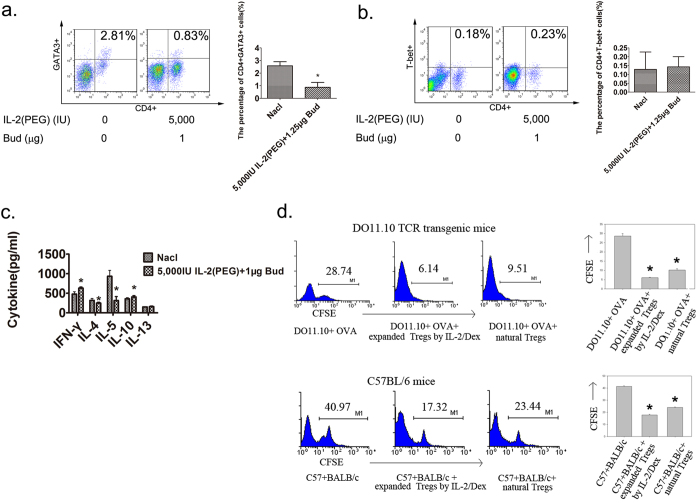
Detection of Th2 cell and cytokines in BALF.Measurements of expanded Treg cells for antigen-specificity. The mechanism of combined use of glucocorticoid and IL-2 in alleviating asthma rested on expanding antigen-nonspecific Treg cells, with a decrease in T helper 2 (Th2) cells and Th2-associated cytokines in the airway. Female BALB/c mice were immunized with OVA i.p on days 1 and 8, followed by intranasal (i.n) 2% OVA challenges on days 9–14. 5,000 IU IL-2 plus 1 μg budesonide (Bud) were administrated intratracheally on days 12–14. On day 15, mice were sacrificed and analyzed by flow cytometry and ELISA. And Treg cells were purified on day 15. (a,b) Detection of CD4+GATA3+ Th2 cell and CD4+T-bet+ Th1 composition among lymphocytes in BALF by flow cytometry. (c) Measurements of cytokines (IL-4, IL5, IL-10, IL-13 and IFN-γ) by ELISA in BALF. (d) Expanded Treg or Treg cells were purified from BALF of asthma model mice after treatment with IL-2 plus dexmethasone (Dex) for 3 days or the spleens of healthy BALB/c mice to be measured for antigen-specificity in OVA-specific proliferation assays and mixed lymphocyte reactions. *p < 0.05. (a,b,c) Data are presented as means ± SEM (n = 6 per group and data point) from 2 independent experiments. Treated group versus untreated group by Student’s t test. (c) Data are presented as means ± SEM (n = 3 per group and data point); here representative results from 1 of 2 experiments are shown. Treg cells addition group versus non-Treg cells group by Student’s t test.